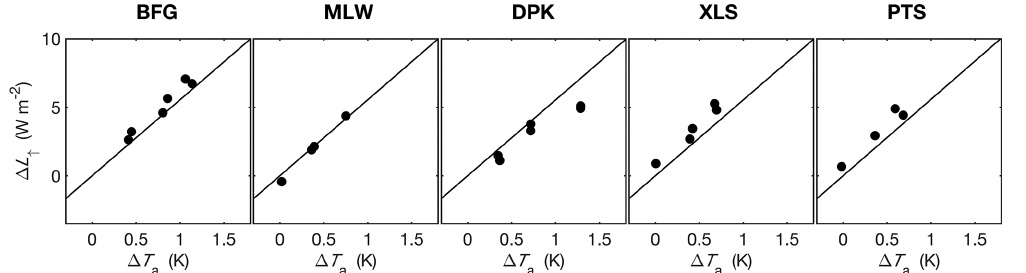
Figure 7. The relationship between changes in observed annual mean upward longwave radiation flux and annual mean air temperature (dots). Solid lines represent the prediction of the Stefan–Boltzmann law.